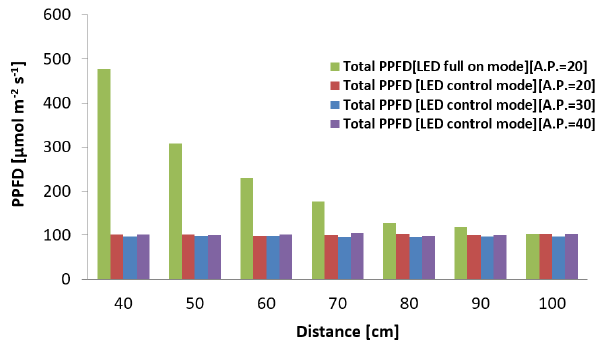
Figure 6. Total PPFD comparison according to various distances and ambient PPFD.